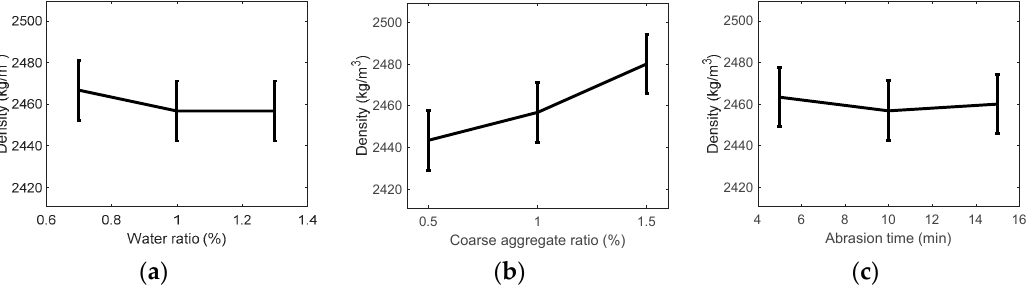
Figure 3. Assumed density of recycled fine aggregate by variance analysis: ( a ) water ratio; ( b ) coarse aggregate ratio; and ( c ) abrasion crusher time.